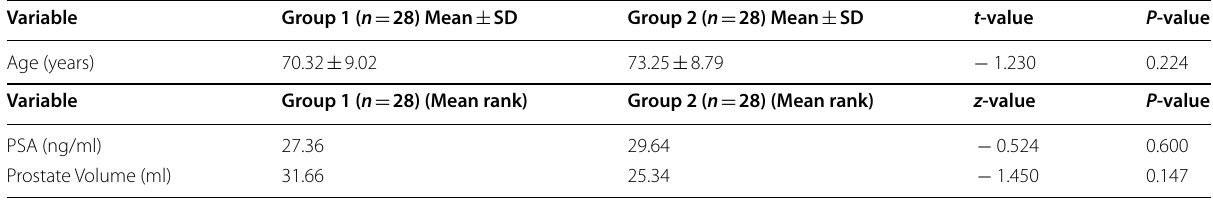
Table 1 The comparison of mean for age, median for prostate volumes, and serum PSA between the two groups Variable